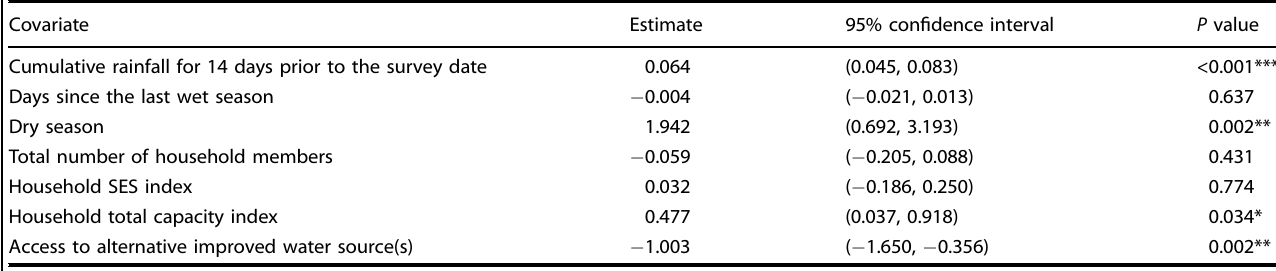
Table 2. Results of the logistic mixed effects model of household rainwater availability using rainfall totals for 9 days preceding the survey.